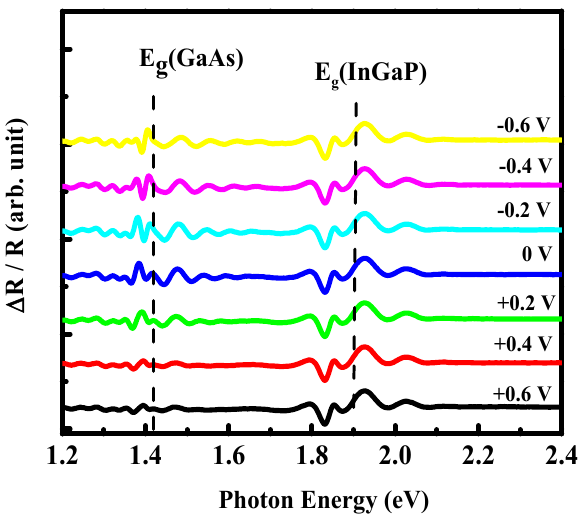
Figure 4. The photoreflectance spectra of InGaP/GaAs dual junction solar cell under zero, 0.2, 0.4, and 0.6 V of the forward and reverse DC bias voltage at 300 K.